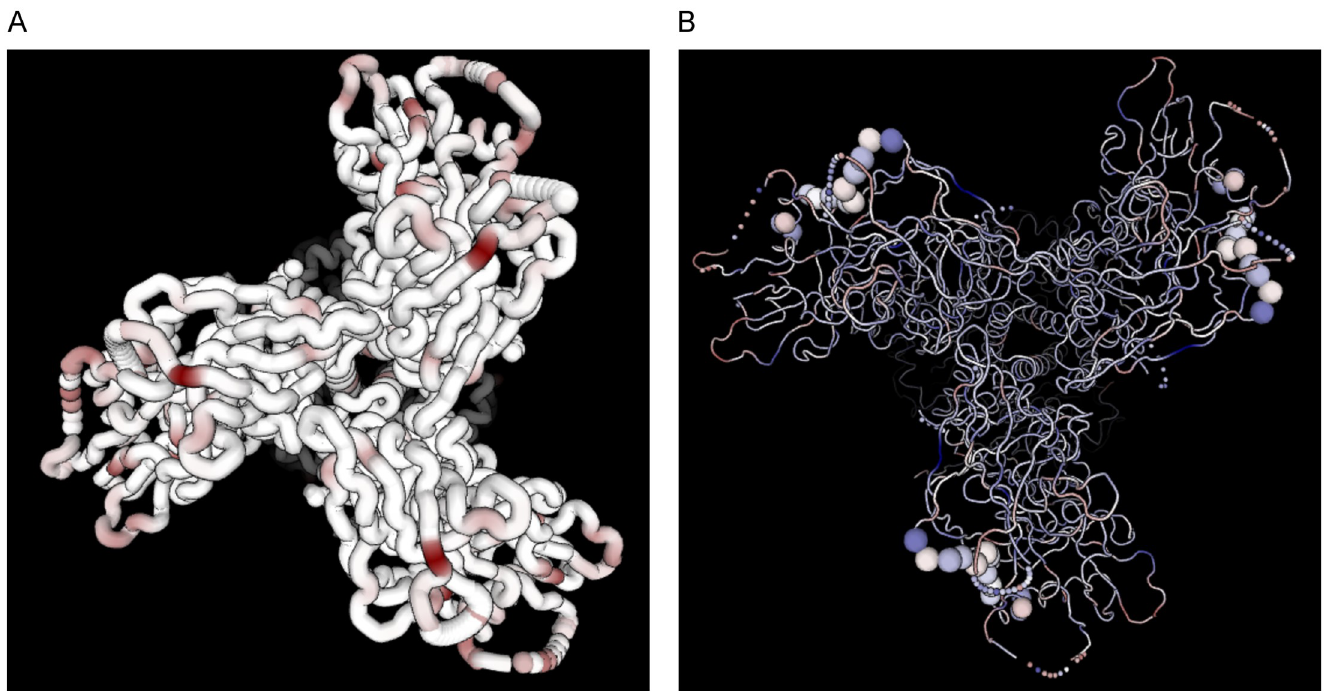
Fig 7. Screenshots of the interactive three-dimensional Env structure, colored according to JS divergence (left) and dN / dS values (right). Positions imputed to be undergoing more positive selection ( dN / dS > 1) are darker red, and positions undergoing more purifying selection ( dN / dS < 1) are darker blue. The right structure also shows motif positions highlighted in the sequence viewer.